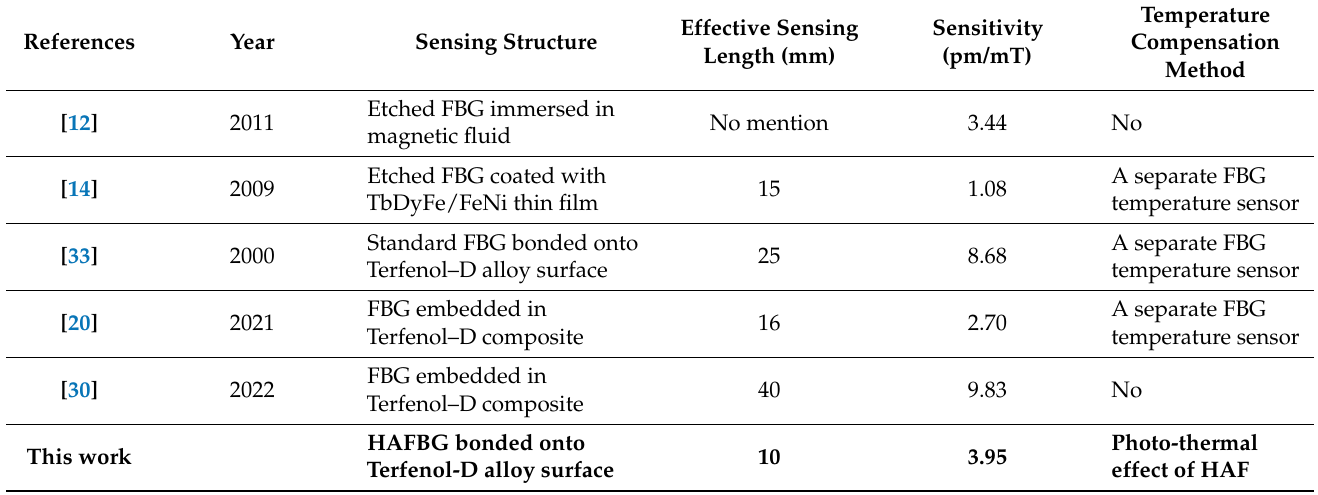
Table 1. Comparison of the representative FBG-based magnetic field